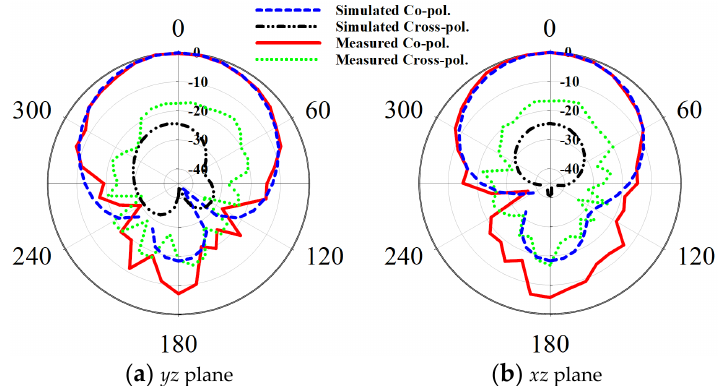
Figure 6. Normalized radiation patterns of direct ink-printed antenna at 2.4 GHz.